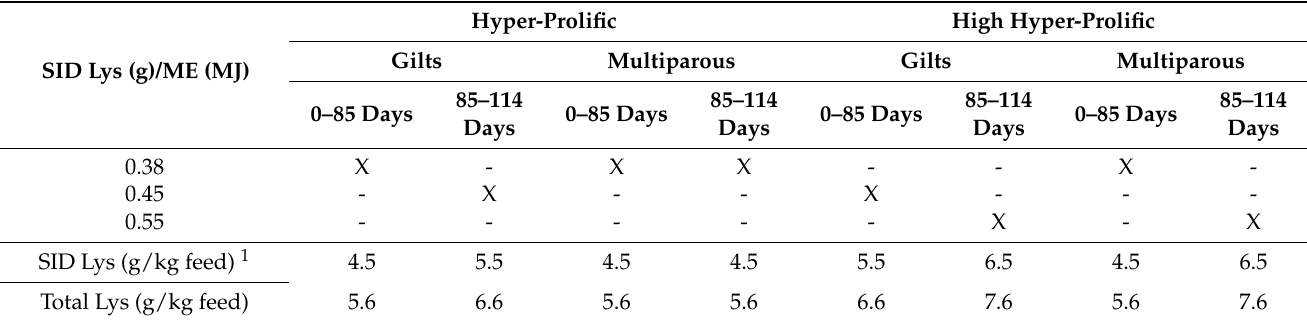
Table 2. Recommended SID Lys/ME ratios and levels of SID Lys and Total Lys (g/kg feed) for the present hyper-prolific and high hyper-prolific gilts and multiparous sows between day 0 to 85 and 85 to 114 of